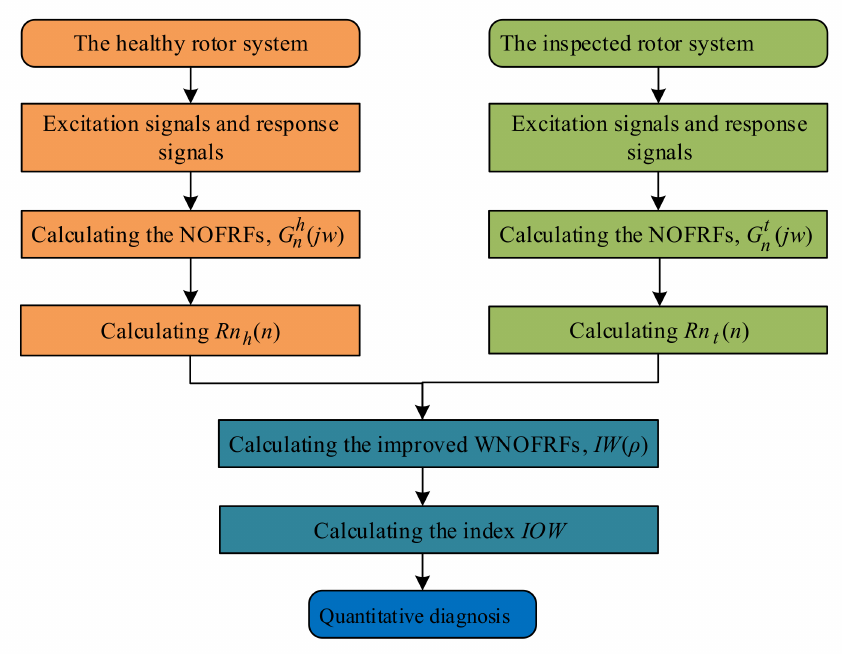
Figure 10. The flow chart of the improved